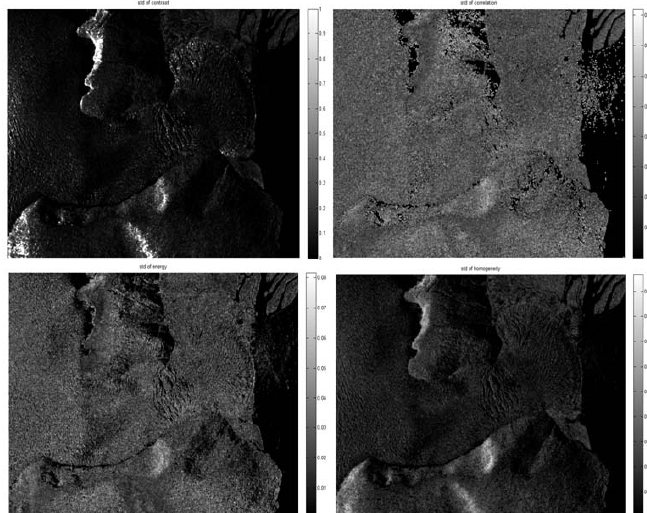
Fig.7. Upper left: standard deviation of contrast. Upper right: standard deviation of correlation. Lower left: standard deviation of energy. Lower right: standard deviation of homogeneity